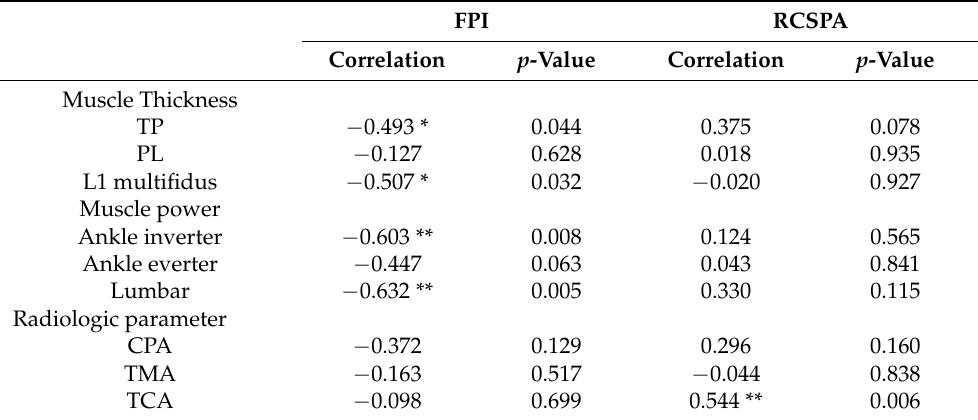
Table 7. Correlation between clinical parameters and muscle thickness, muscle power, and the radiologic parameters for male participants (n = 12).